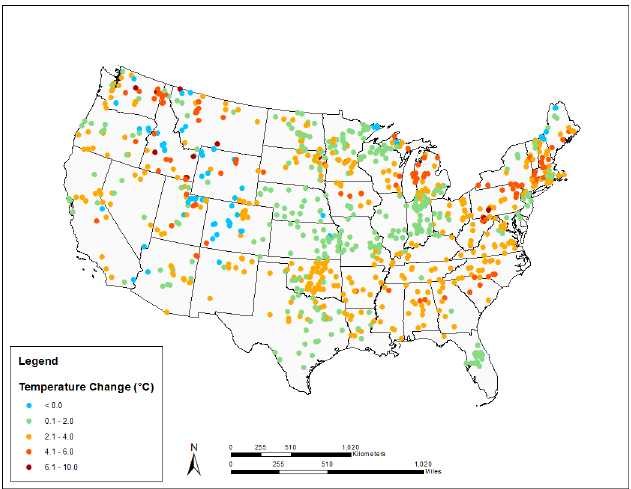
Fig 3. Simulated changes in summer MWATs above the thermocline for NLA lakes, ca. 2065 (median across climate scenarios).